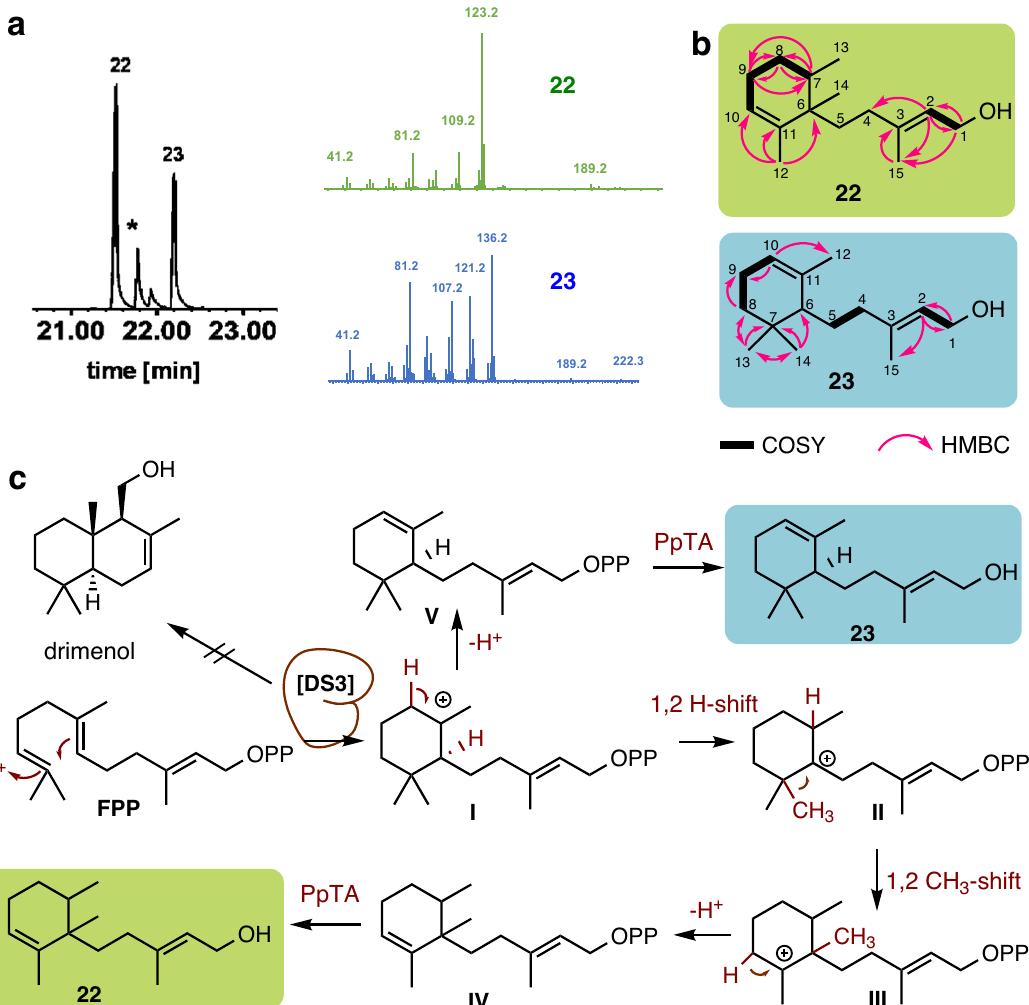
Fig. 7 Enzyme assays with puri fi ed DS3-His6 protein yielded monocyclofarnesyl derivatives. a GC-chromatogram of product spectrum after incubation of DS3 with FPP in the presence of MgCl 2 and MS 2 -spectra of products 22 , 23 , and side product farnesol (*). b Key 1 H- 1 H COSY and HMBC correlations of isolated compounds 22 and 23. c Proposed DS3-His6 catalyzed cyclisation of FPP and subsequent catalytic steps (in dark red) by enzyme DS3-His6 and a homolog of a phosphatidic acid phosphatase (PpTA), which result in the formation of products 22 and 23